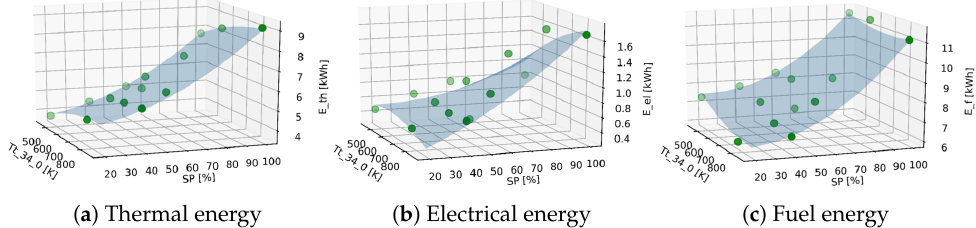
Figure 4. The 2D interpolating maps allowing obtaining the energy produced during transient maneuvers. Starting from a recuperator temperature (left horizontal axis) and given the final SP (right horizontal axis), the thermal, electrical, and fuel energy can be read on the vertical axis,